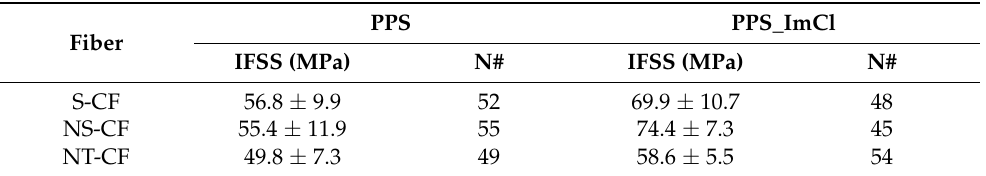
Figure 9. IFSS results obtained for PPS and PPS_ImCl with S-CF, NS-CF, NT-CF. Table 9. Interfacial Shear Stress (IFSS) for different Carbon fiber/PPS matrix interfaces as a function of the surface treatment of carbon fiber and of the presence of ionic salt.